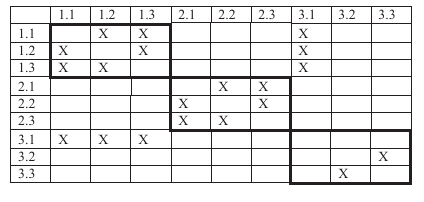
FIG. 4. Example of an expertlike card sort and the calculation of the score.